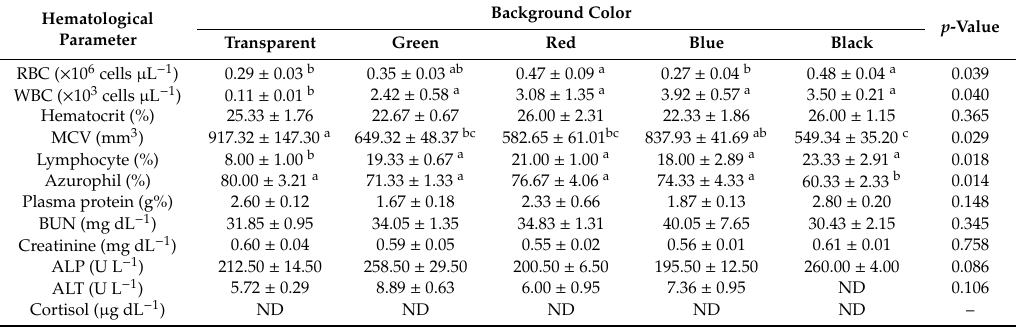
Table 4. Hematological parameters of northern river terrapins reared with various background colors. The sampling represents the end of the twelve-week